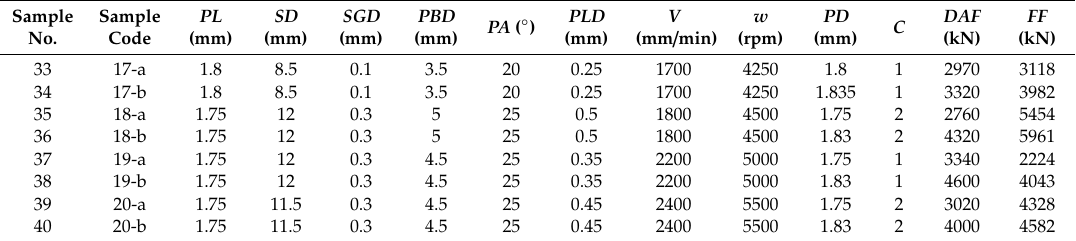
Table 3. Some more experiments conducted to explore more regarding the e ff ect of tool and process parameters on downward axial force and fracture force.